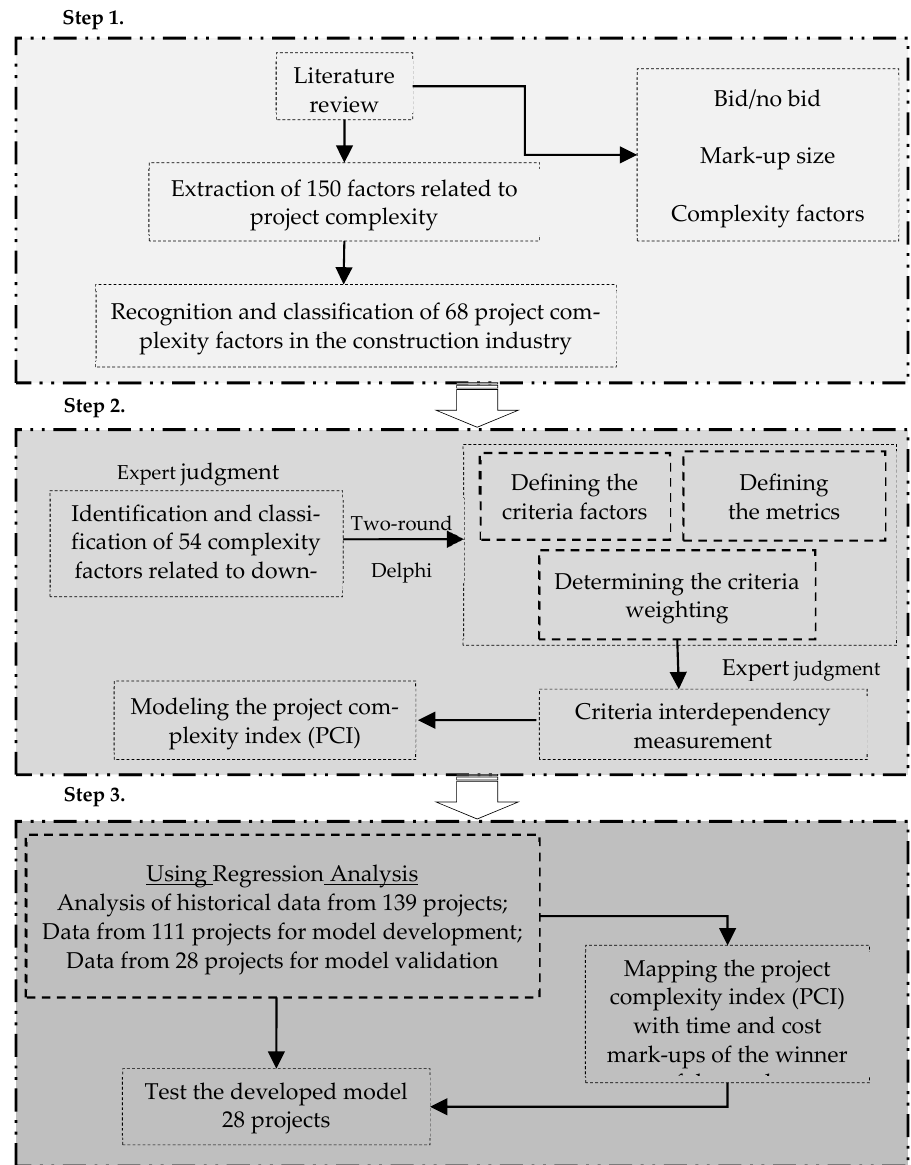
Figure 3. Research methodology.